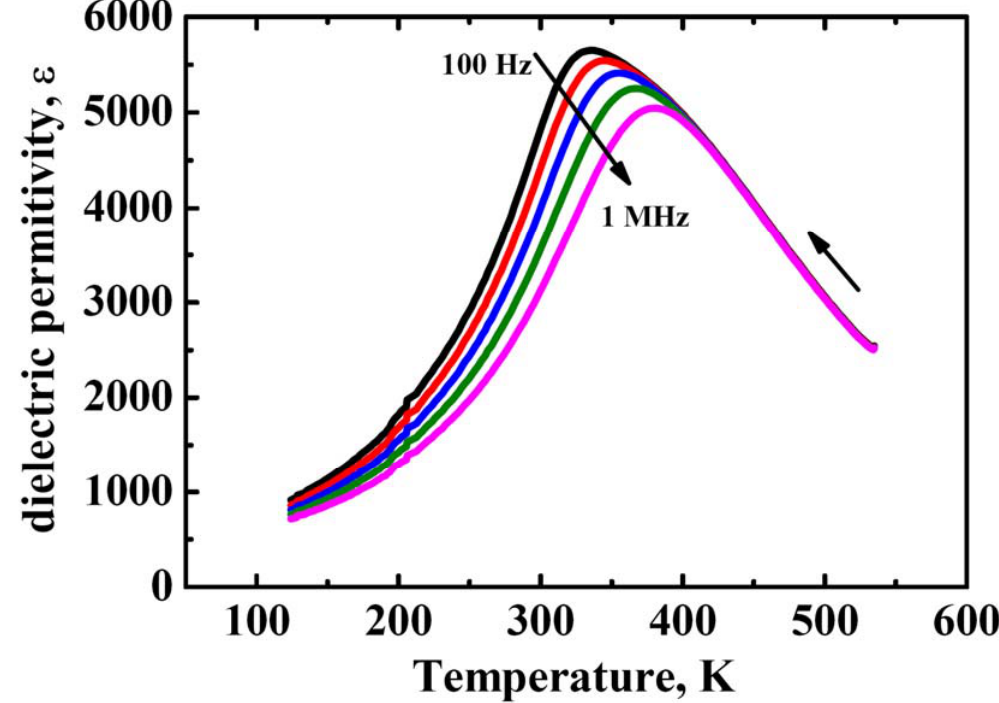
Figure 2. Temperature dependence of dielectric permittivity ε (T) of PLZT-9.75/65/65 ceramics, measured at different